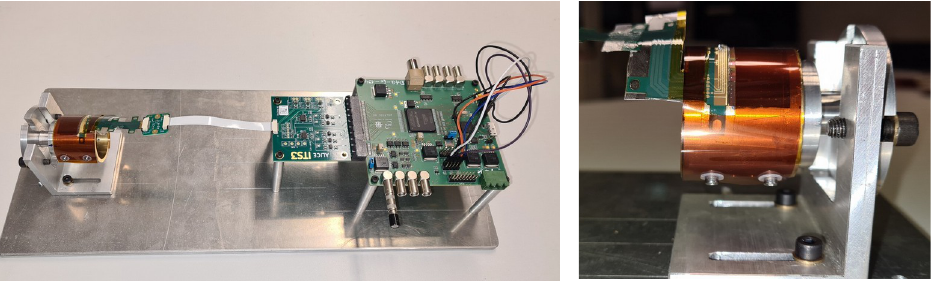
Fig. 2. (left) Setup assembled for the electrical tests with the ALPIDE bent over a cylindrical jig. (right) Closed view if the ALPIDE bent along its long side over the cylindrical jig and held in position with a kapton foil screwed at the